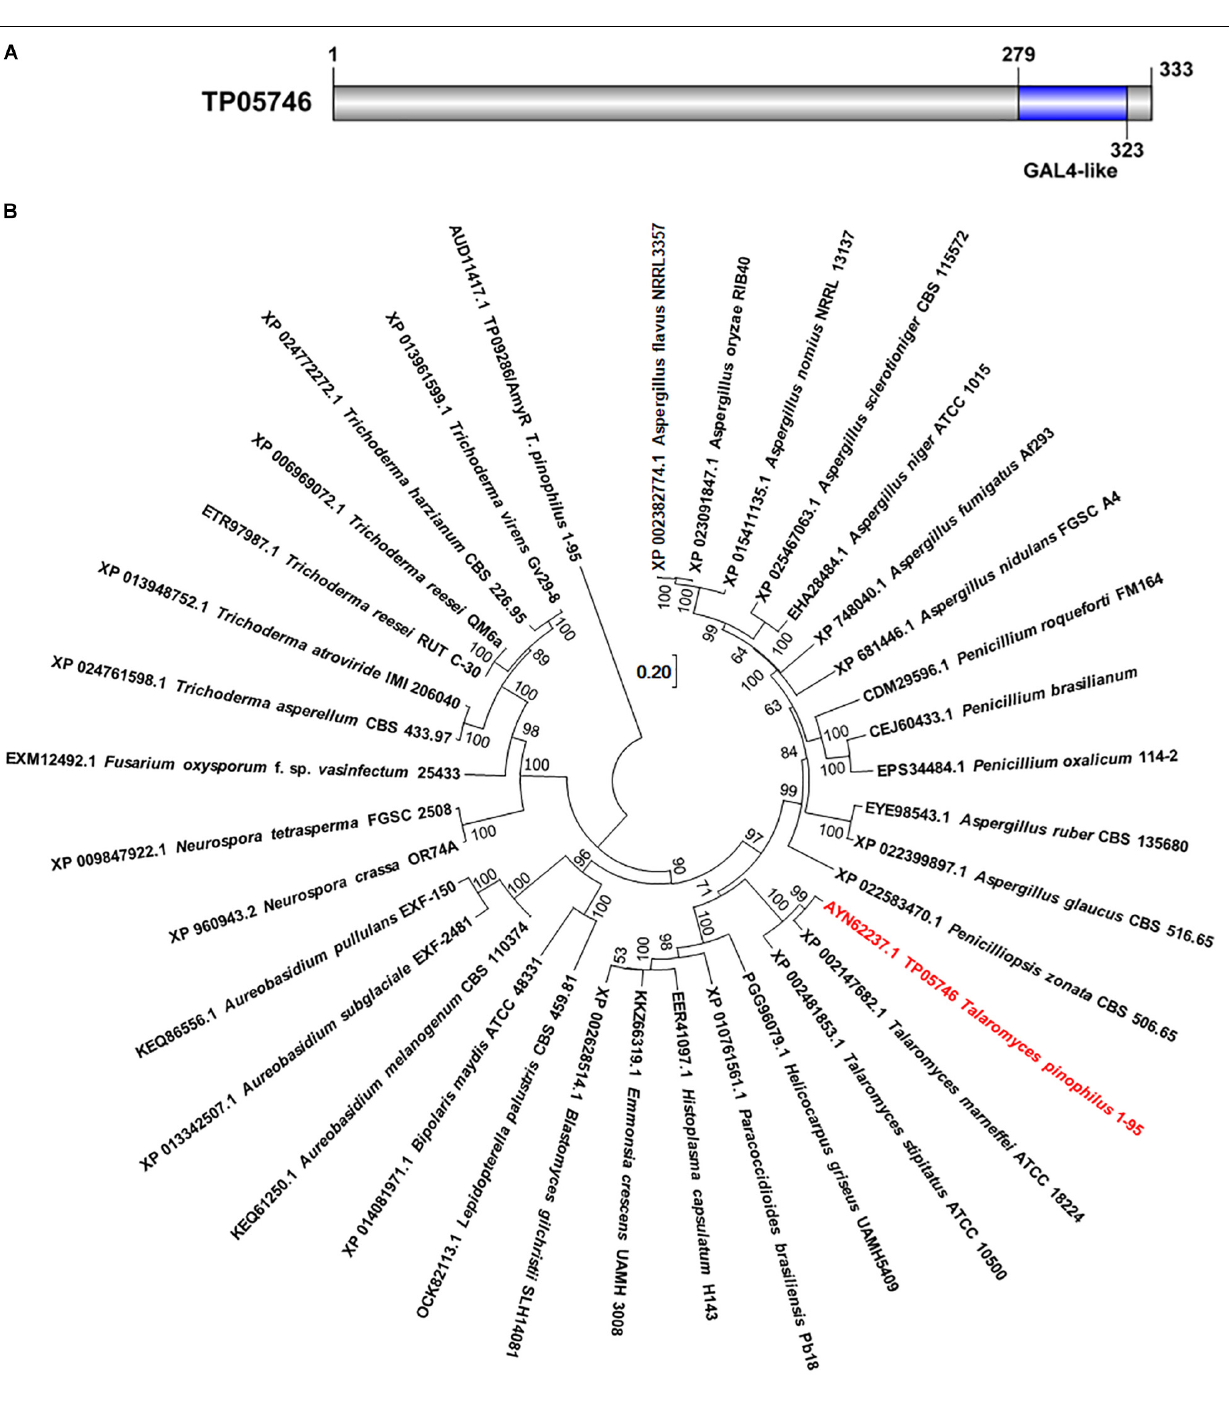
FIGURE 1 | Characterization of TP05746 from Talaromyces pinophilus . (A) Conserved domain in TP05746. (B) Phylogenetic analyses of TP05746 and its homologous proteins. The cladogram was constructed by software MEGA7 based on the neighbor-joining method and a Poisson correction model. Scale bar indicates branch